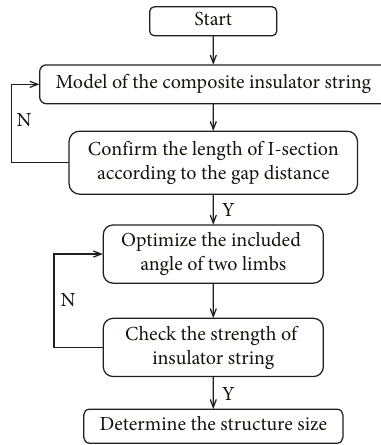
Figure 13: Te optimization fow